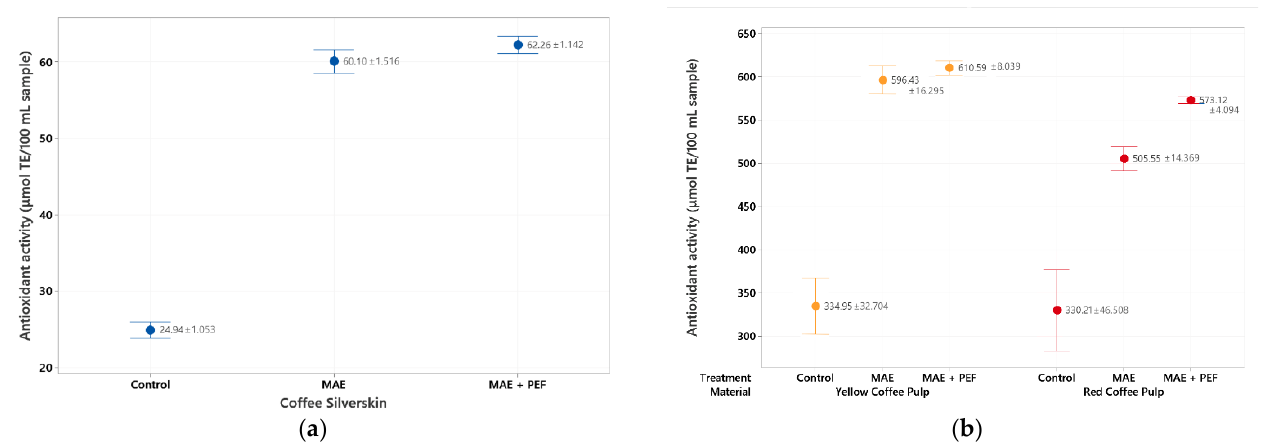
Figure 4. ABTS antioxidant assay of coffee agro-waste extracts. Values are represented as mean ± standard deviation ( n = 3). TE: Trolox equivalents. ( a ) Assay results for parchment waste. ( b ) Assay results for yellow and red pulp waste. MAE: Microwave assisted extraction; PEF: Pulsed Electric Field pretreatment.